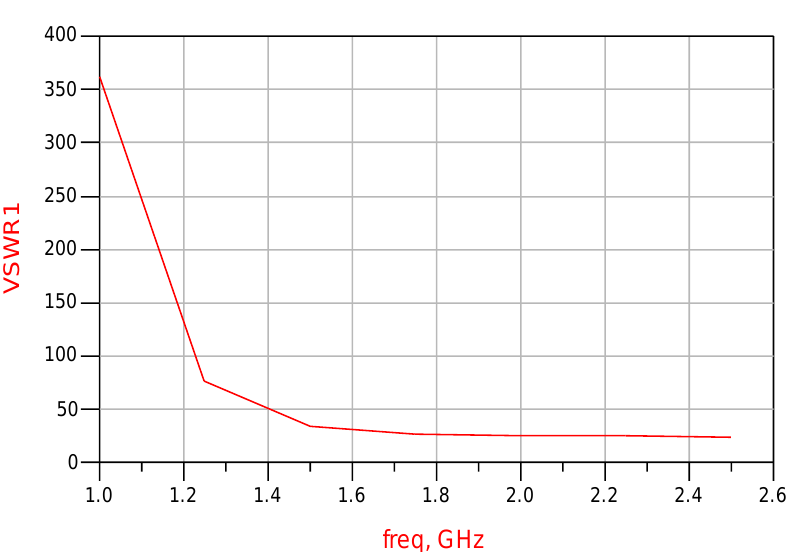
Figure 6. Chart stability.